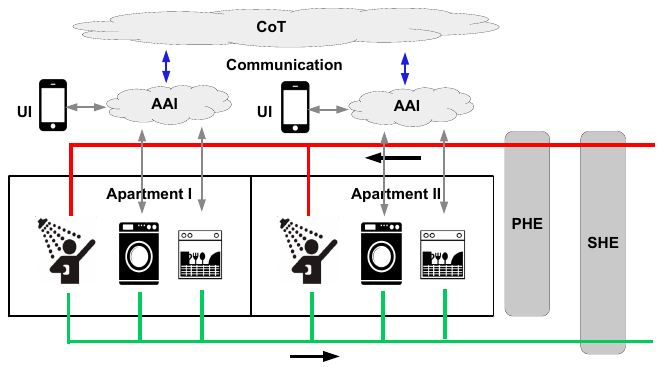
Figure 3. A residential building that contains two AI equipped smart apartments.